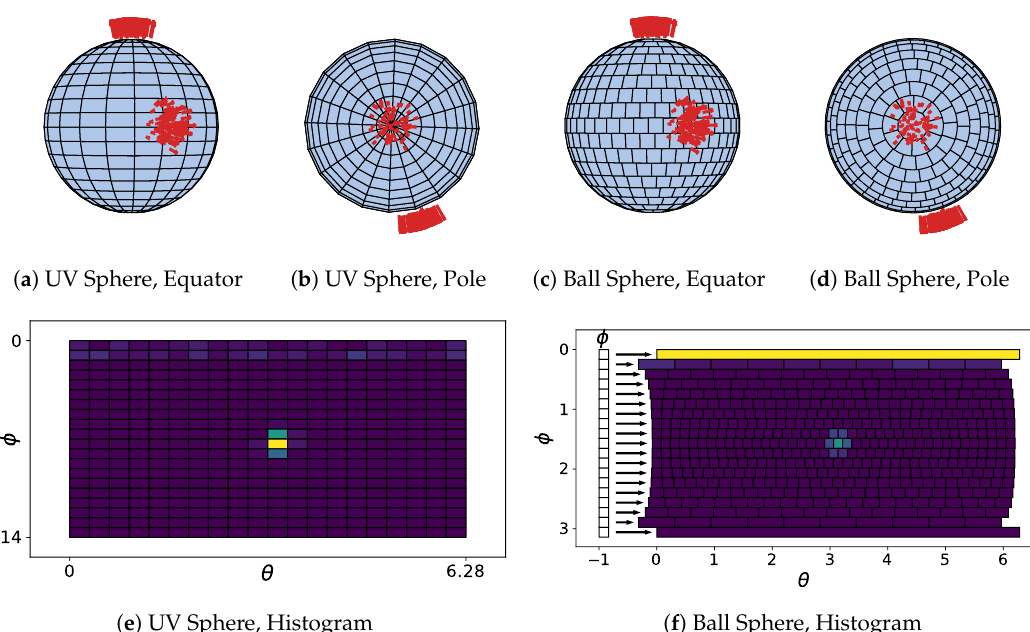
Figure 3. Examples of integrating normals from two identically “noisy” planes (red arrows, Gaussian distributed) into a UV Sphere ( a , b ) and Ball Sphere ( c , d ). Note the anisotropic property of sphere cells caused by unequal area and shape; ( e ) The UV Sphere histogram is unable to detect the peak at the pole; ( f ) The Ball sphere is able to detect both peaks, but the north pole cell is significantly larger leading to an incorrectly higher value than the equator